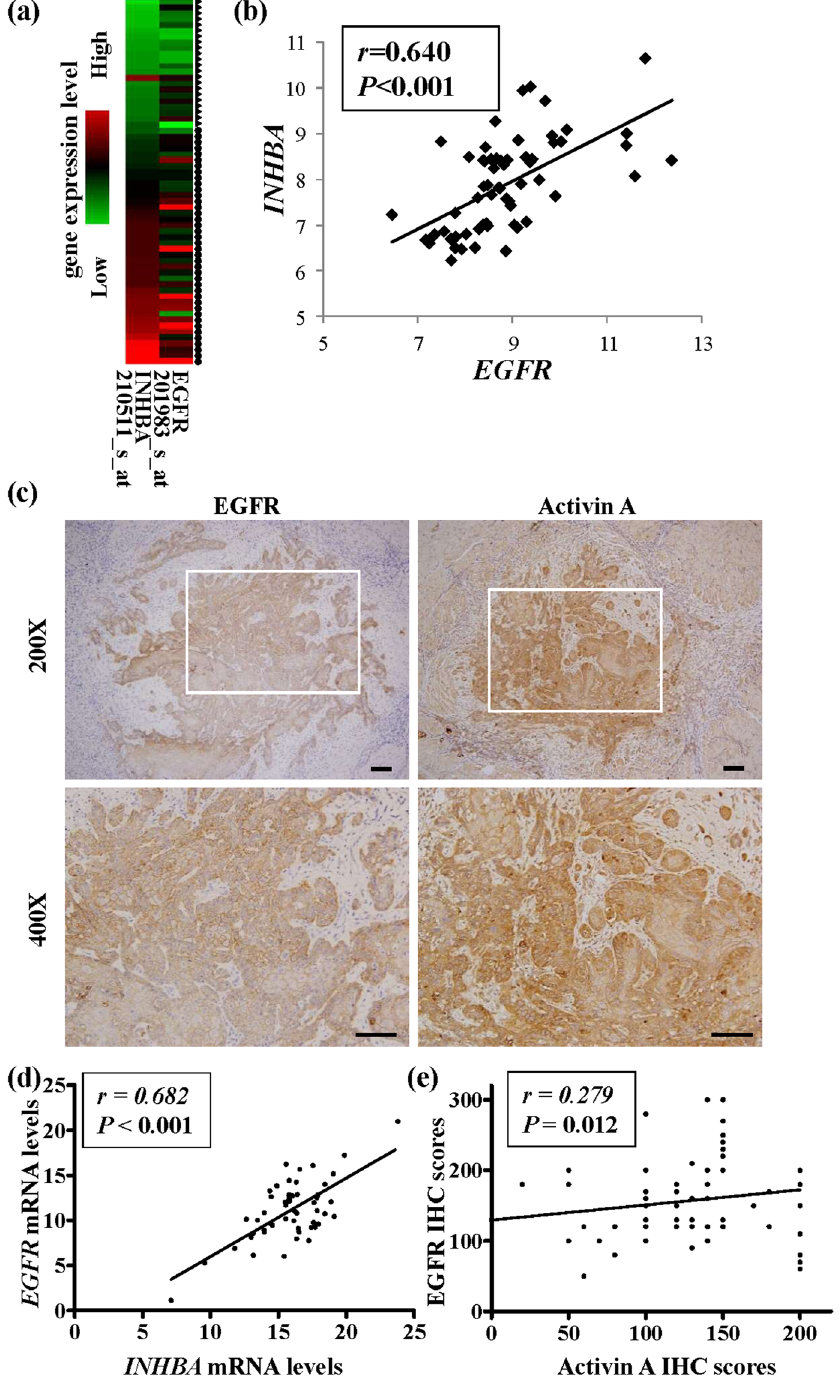
Figure 1. Overexpression and correlation of activin A and EGFR in OSCC tissues. ( a ) The correlation of INHBA expression and EGFR expression in OSCC tissues was analyzed using Affymetrix U133A chip data. Transcripts of INHBA and EGFR in normal ( n = 22) and OSCC tissues ( n = 40) were analyzed using data from Affymetrix U133A chips. Total RNA was isolated from each OSCC and normal sample. Triangle: normal tissue; Circle: OSCC tissue. The probe set numbers of these two genes are shown on the X-axis; gene expression levels of each sample are shown on the Y-axis. Red indicates high transcript expression; green indicates low expression. ( b ) The correlation between INHBA and EGFR transcripts in OSCC tissues ( n = 40) was analyzed by performing Pearson’s correlation analysis. Each squared spot indicates array (chip) data for a patient, and the X-axis and Y-axis represent the log2 ratio value of EGFR and INHBA on the chip, respectively. ( c ) Immunohistochemical staining of activin A and EGFR in OSCC tumor tissues from one representative case (scale bar: 100 μ m). Expression (brown staining) of activin A and EGFR indicates that these proteins localized in the membrane or cytoplasm of OSCC tumor cells. Images shown in the box (upper panel,